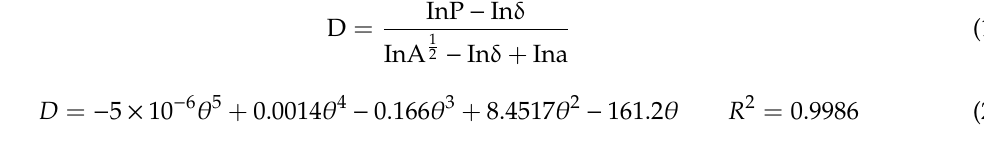
Table 5. Effects of surfactant on the fractal dimension of phosphogypsum.